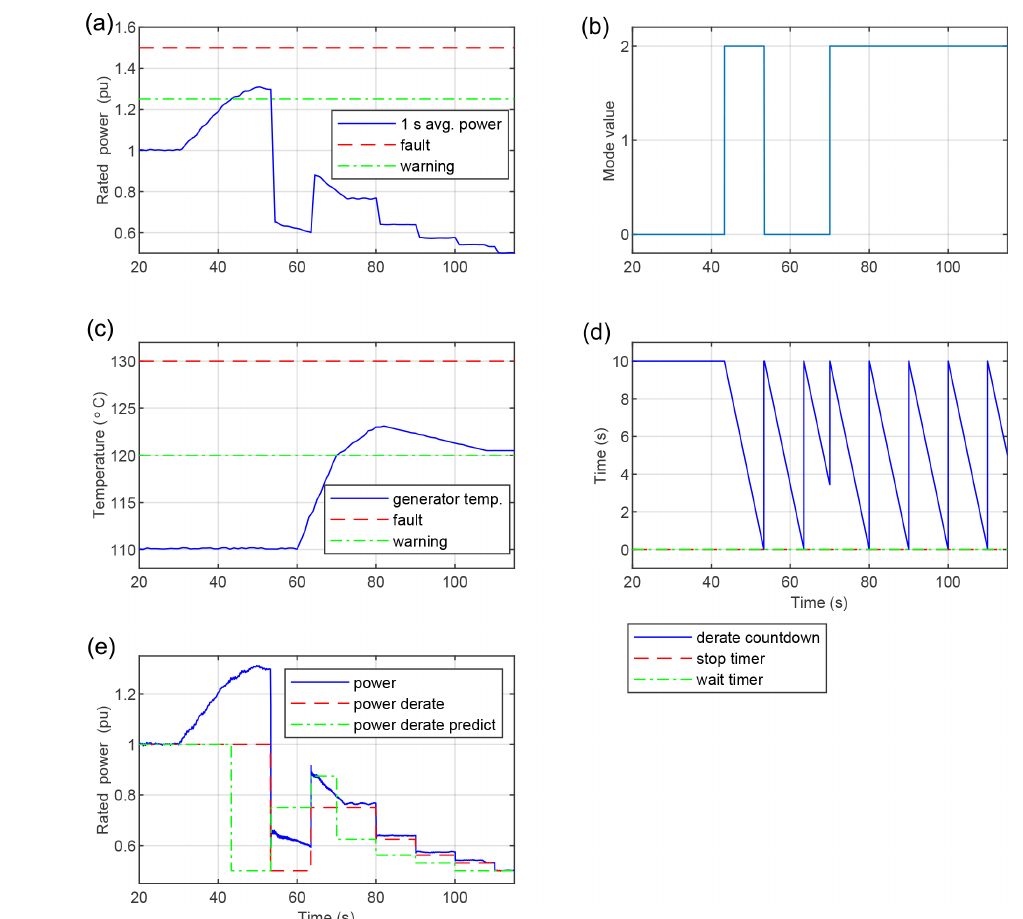
Figure 7. Case 3 scope. Interaction between two derate warnings. Derating mitigates the first warning, and the power command begins to step up, but the appearance of a second warning drives the power command to step back down. (a) The 1s average power, with fault and warning thresholds. (c) Generator temperature, with fault and warning thresholds. (e) Power prediction, command, and output. (b) Mode value: 0 = no warning, 2 = wait warning. (d) Timers. In derate warning mode, derate countdown counts down from the user-defined max time. Each time it reaches zero, power command steps down if in derate warning mode or up if not. The timer resets when derate warning mode toggles